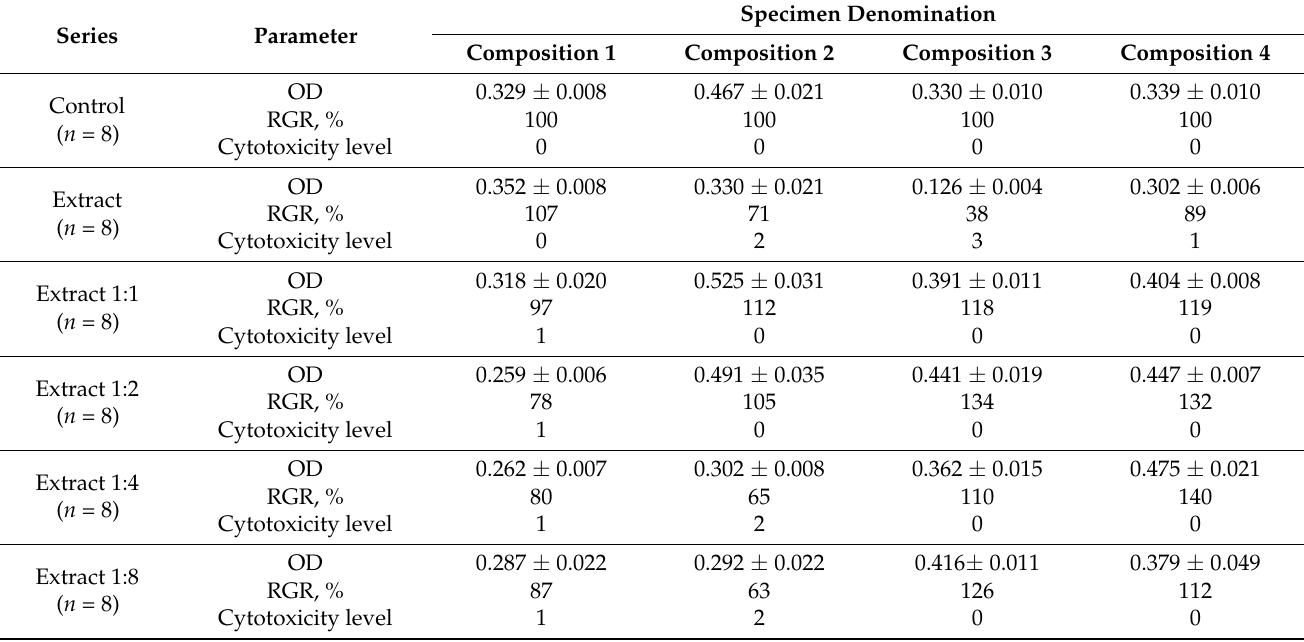
Table 3. Cytotoxicity evaluation of polyurethane polymer specimens at 7 day